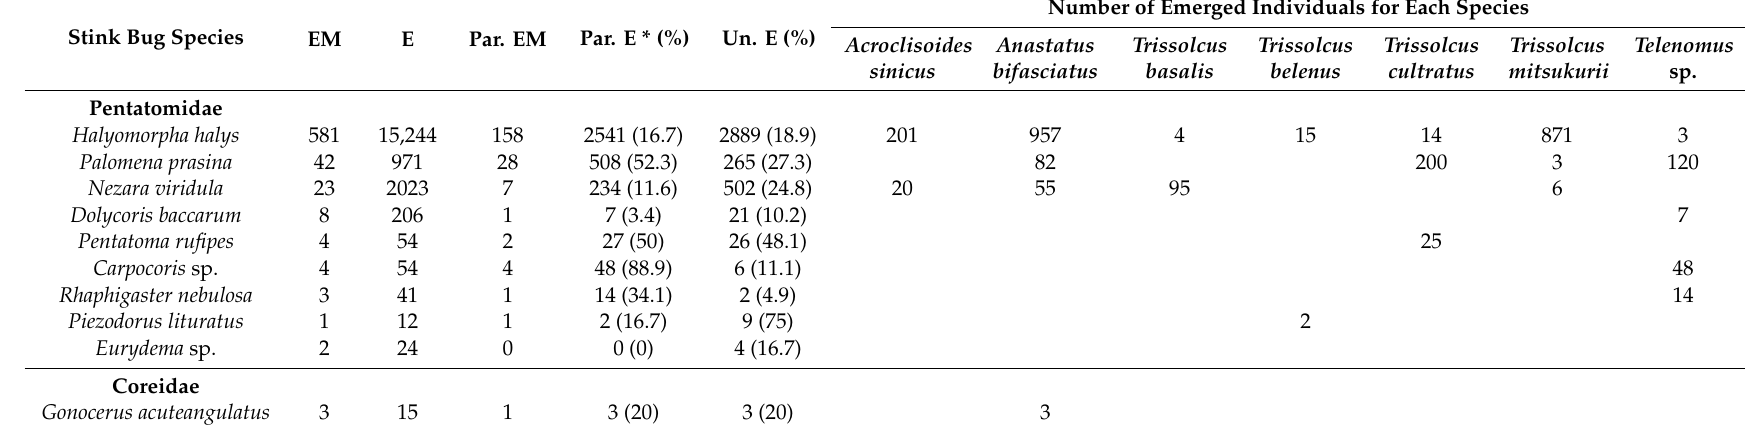
Table 1. Collected stink bug species and emerged parasitoids of naturally occurring egg masses (EM: number of egg masses; E: number of eggs; Par: parasitized; Un: unhatched). * Parasitized Eggs include eggs collected after the emergence of parasitoids, according to the characteristics of exit holes.